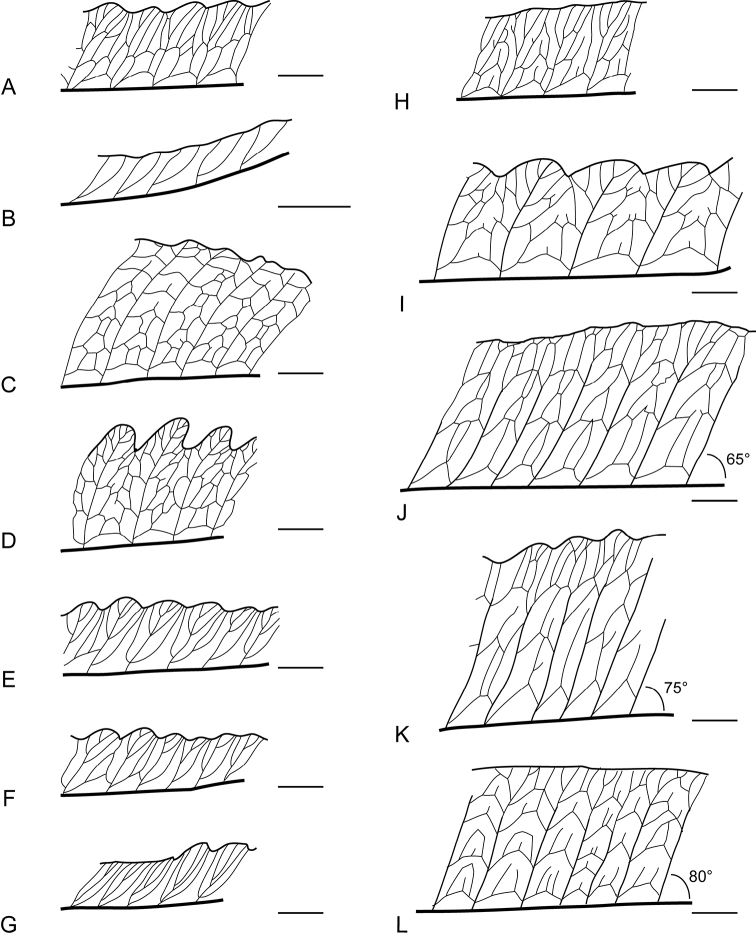
Venation patterns of sterile pinnae from all species of Bolbitis in Taiwan ABolbitis
angustipinna (Y.-F. Huang 176, TAIF) BBolbitis
appendiculata (Y.-F. Huang 243, TAIF) CBolbitis
heteroclita (Y.-F. Huang 221, TAIF) DBolbitis
heteroclita
×
subcordata (Y.-F. Huang 366, TAIF) EBolbitis
laxireticulata (Y.-F. Huang 228, TAIF) FBolbitis
×
nanjenensis (Y.-F. Huang 213, TAIF) GBolbitis
rhizophylla (Y.-F. Huang 124, TAIF) HBolbitis
scalpturata (Y.-F. Huang 164, TAIF) IBolbitis
subcordata (Y.-F. Huang 254, TAIF) JBolbitis
lianhuachihensis (holotype specimen, Y.-S. Chao 3006, TAIF) KBolbitis
hainanensis (holotype specimen, C. Wang 35870, PE) LBolbitis
virens
var.
compacta (type specimen, Tagawa et al. 6802, L). The angles of veinlets to costae are indicated in B.
lianhuachihensis (J), B.
hainanensis (K), and B.
virens
var.
compacta (L). Scale bars: 5 mm.